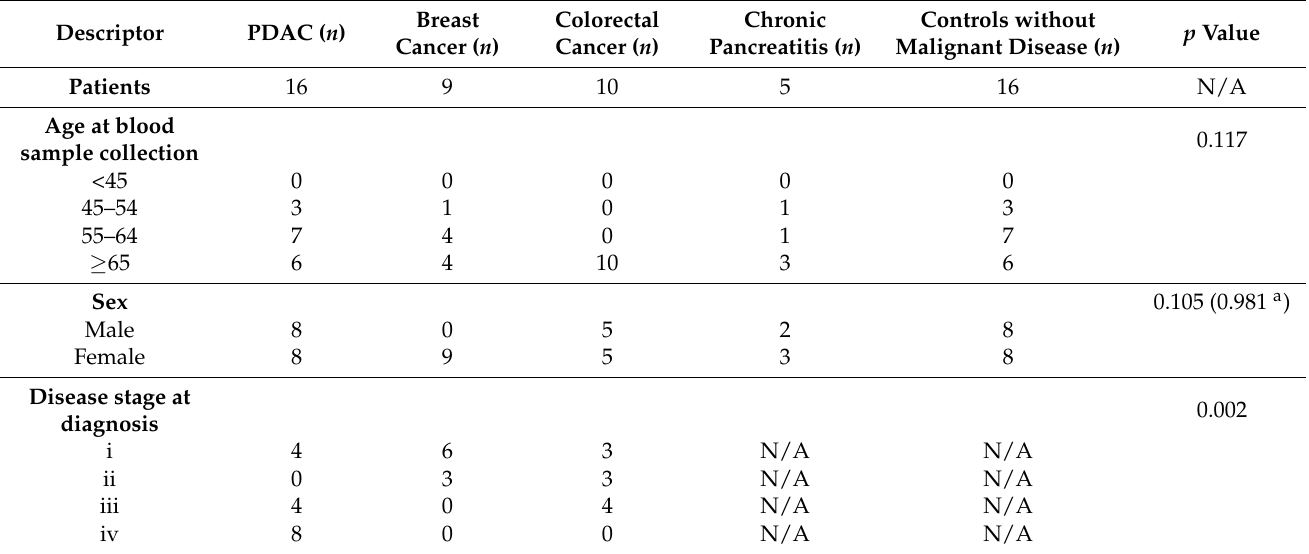
Table 2. Description of patient samples at diagnosis from the Umeå prospective clinical